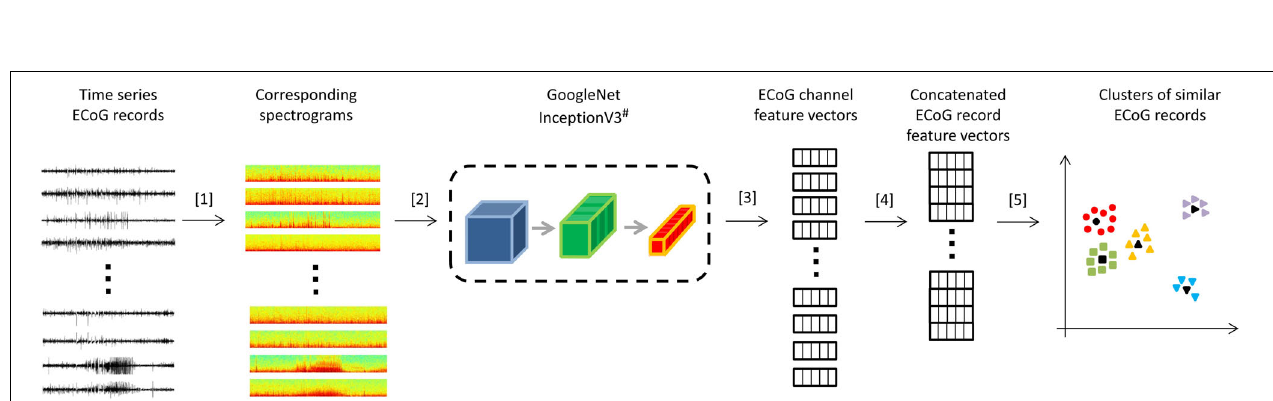
FIGURE 4 | Steps for creating 2D embeddings of patient-specific ECoG records. [1] Each channel in the time series electrocorticographic (ECoG) record was converted to a spectrogram image after removal of stimulation artifacts. [2] Spectrogram image (size 224 × 224 × 3) of each ECoG channel was passed to a pre-trained GoogLeNet Inception-V3 model for feature extraction. [3] The convolutional neural networks (CNN) extracted a feature matrix of dimensions 8 × 8 × 2048 for each spectrogram image. The feature matrix was flattened to create a feature vector of length 131,072. [4] Four feature vectors corresponding to the four channels in an ECoG record were concatenated to create a feature vector of length 524,288 for each ECoG record. Vectors of zeros were substituted for missing channels. [5] Dimensionality reduction with PCA and t-SNE was performed on the concatenated feature vectors to represent ECoG records in 2-dimensional patient-specific embedding spaces. Unsupervised clustering of the resulting 2D data was performed. ECoG records closest to cluster centers (shown in black) were identified and presented to the human labeler. # Cartoon representation of the GoogleNet Inception-V3 CNN model. Please refer to https://cloud.google.com/tpu/ docs/inception-v3-advanced for details about the GoogleNet Inception-V3